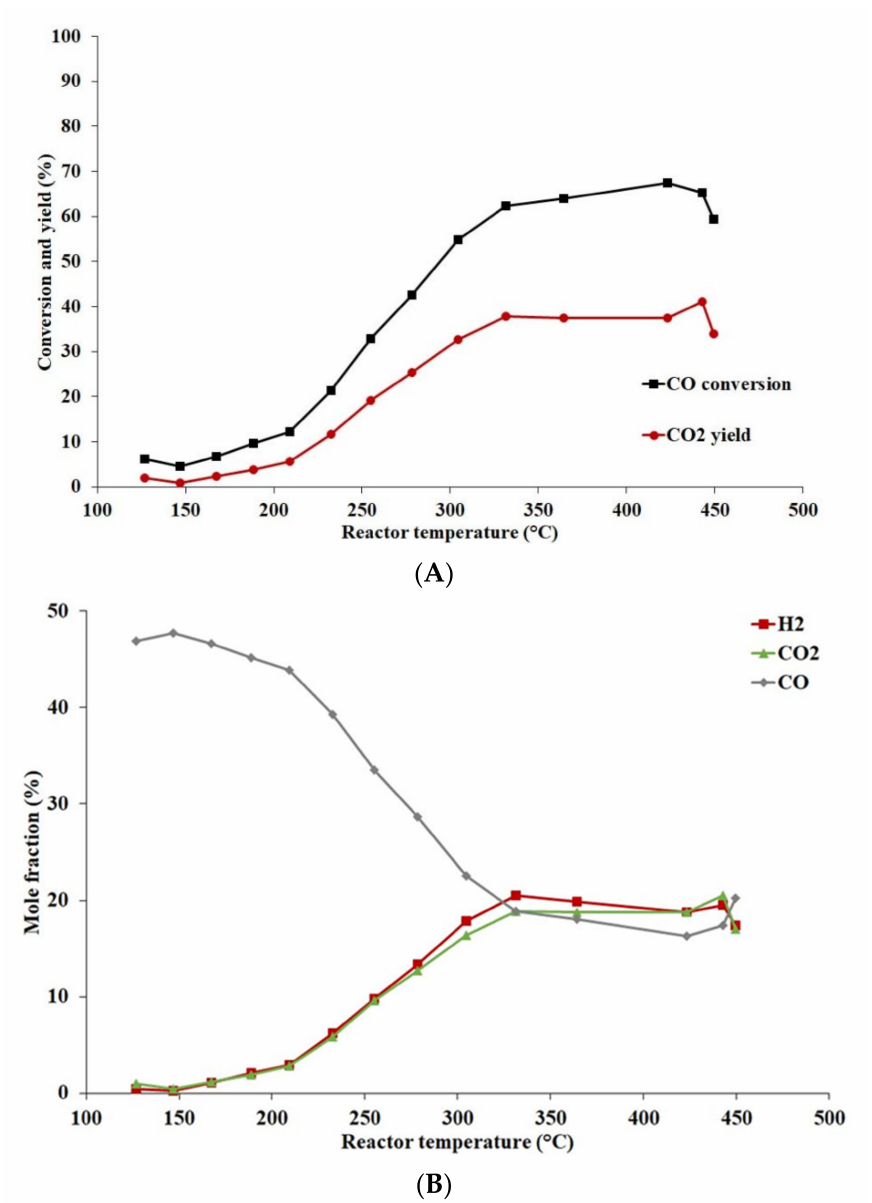
Figure 9. Catalytic tests with feed gas mixture 1 (50 mole% CO, 50 mole% N 2 ) at pressure 0.5 MPa over a Cu-based (11.4 wt%) catalyst prepared with non-calcined support: ( A )—CO conversion and CO 2 yield over a non-activated catalyst; ( B )—all product over a non-activated